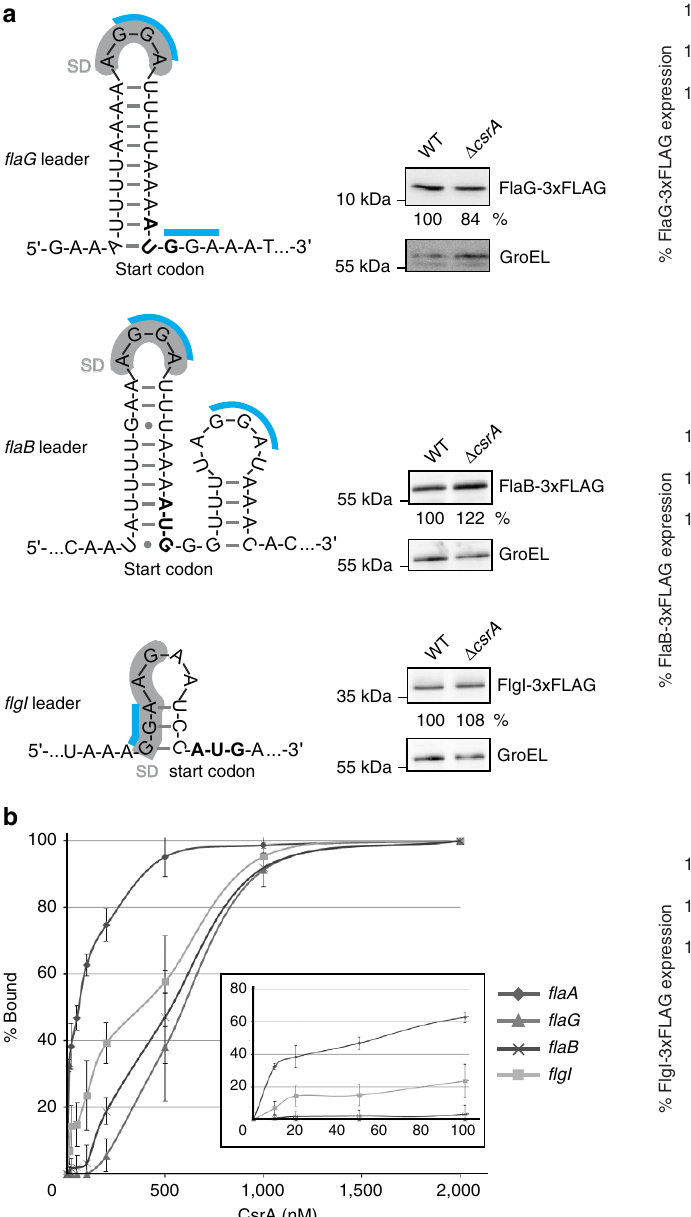
Figure 4 | CsrA binds to other flagellar target mRNAs but csrA deletion does not affect their translation. ( a ) (Left) Predicted secondary structures of flaG, flaB and flgI leaders using Mfold 74 with putative GGA binding-sites of CsrA (blue) and SD sequences (grey). (Right) Western blot analyses of FlaG-3xFLAG, FlaB-3xFLAG and FlgI-3xFLAG in C. jejuni WT or D csrA strains. ( b ) CsrA-binding affinities of flagella mRNA leaders ( r 4nM) determined by in vitro gel-shift assays. The inset represents an enlargement of the binding curves for low CsrA concentrations. Shown is the mean ± s.d.